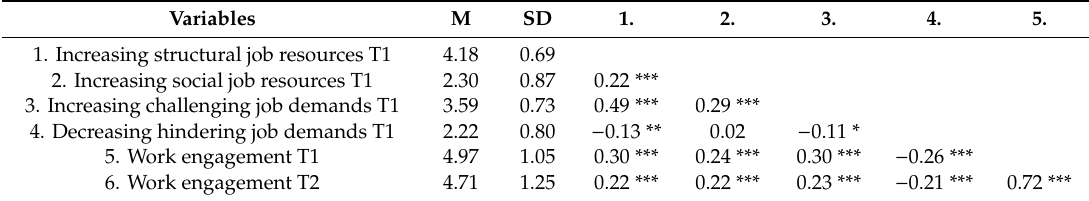
Table 2. Means, standard deviations, and Pearson correlations of study variables among participants not facing changes in work content ( n =